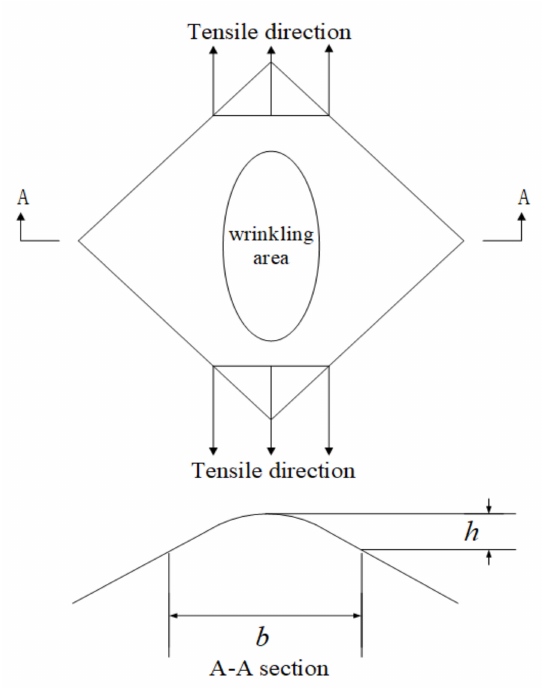
Figure 1. Schematic of the